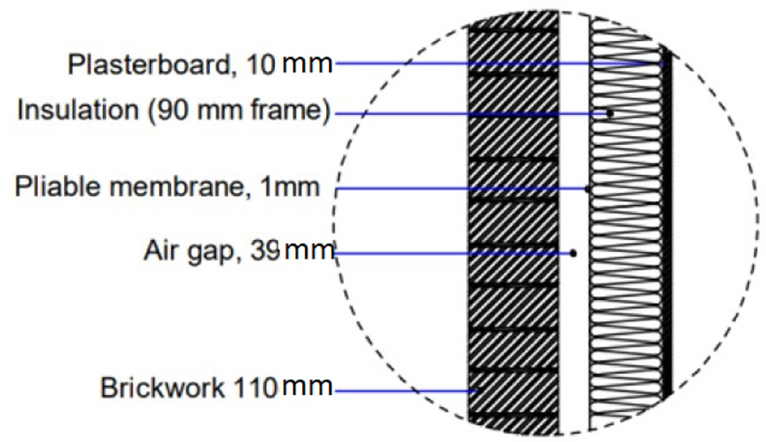
Figure 5. Section drawing of timber-framed brick veneer wall system.